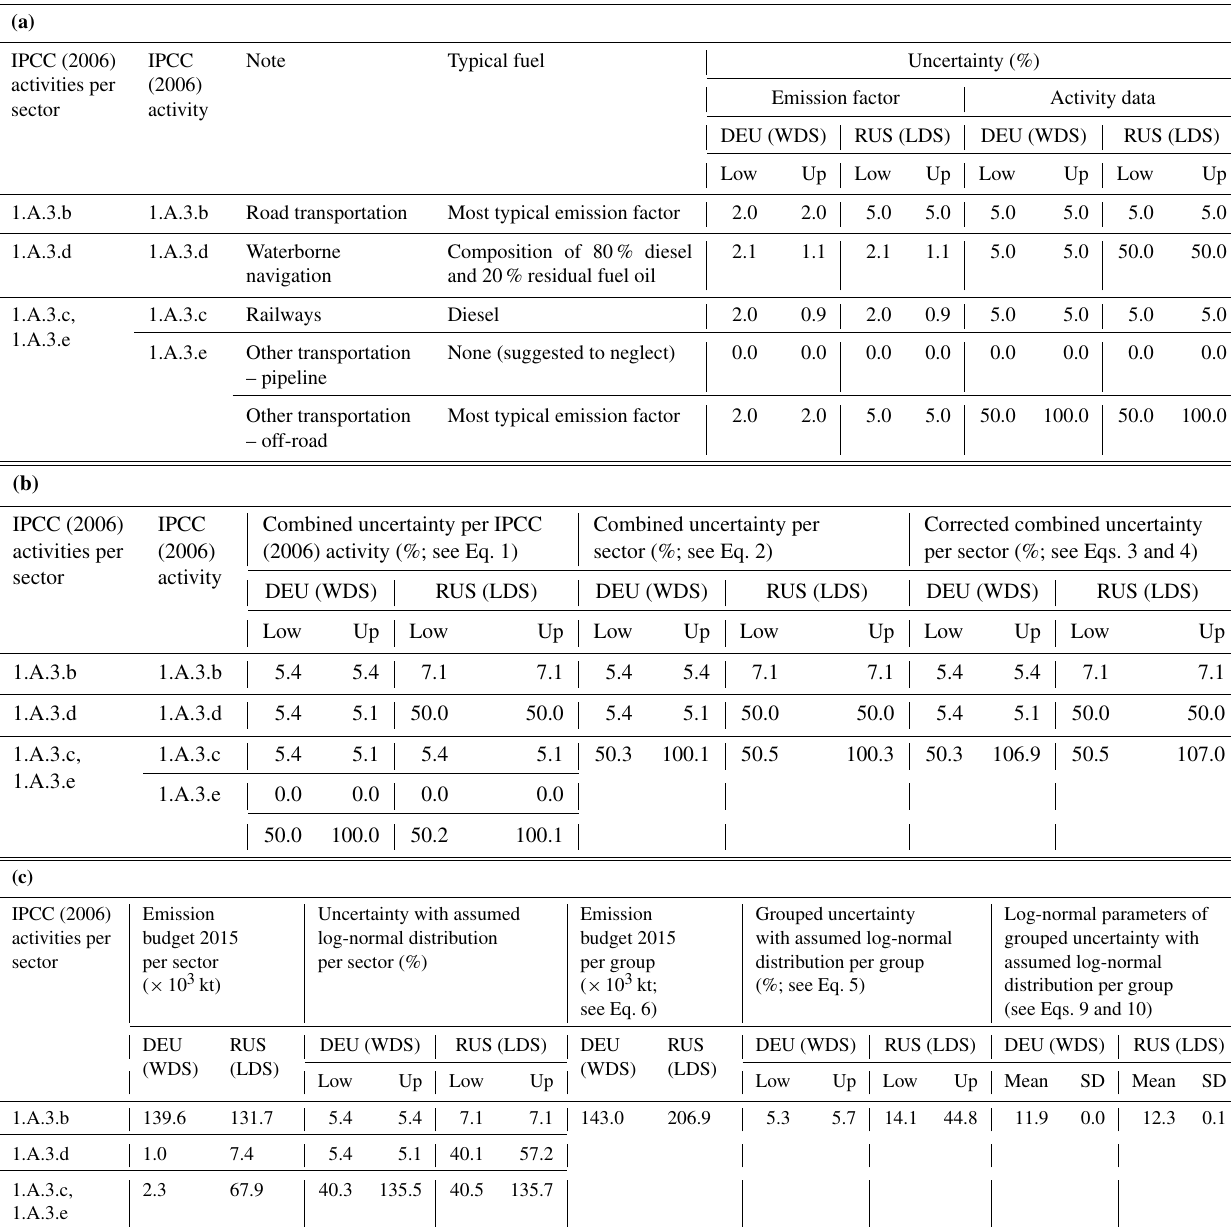
Table 4. Yearly uncertainty calculation steps. Example shows TRANSPORT group uncertainty calculations for Germany (DEU) and the Russian Federation (RUS), countries with a well- (WDS) and less well-developed statistical infrastructure (LDS), respectively. (a) Prepara- tory step (data collection) – same values are applied for all countries with the same development level of statistical infrastructure. (b) First step – same values are applied for all countries with the same development level of statistical infrastructure. (c) Second step – values are specific per geographical entity considering countries’ development level of statistical infrastructure and emission budget (values are from CHE_EDGAR-ECMWF_2015); SD stands for standard